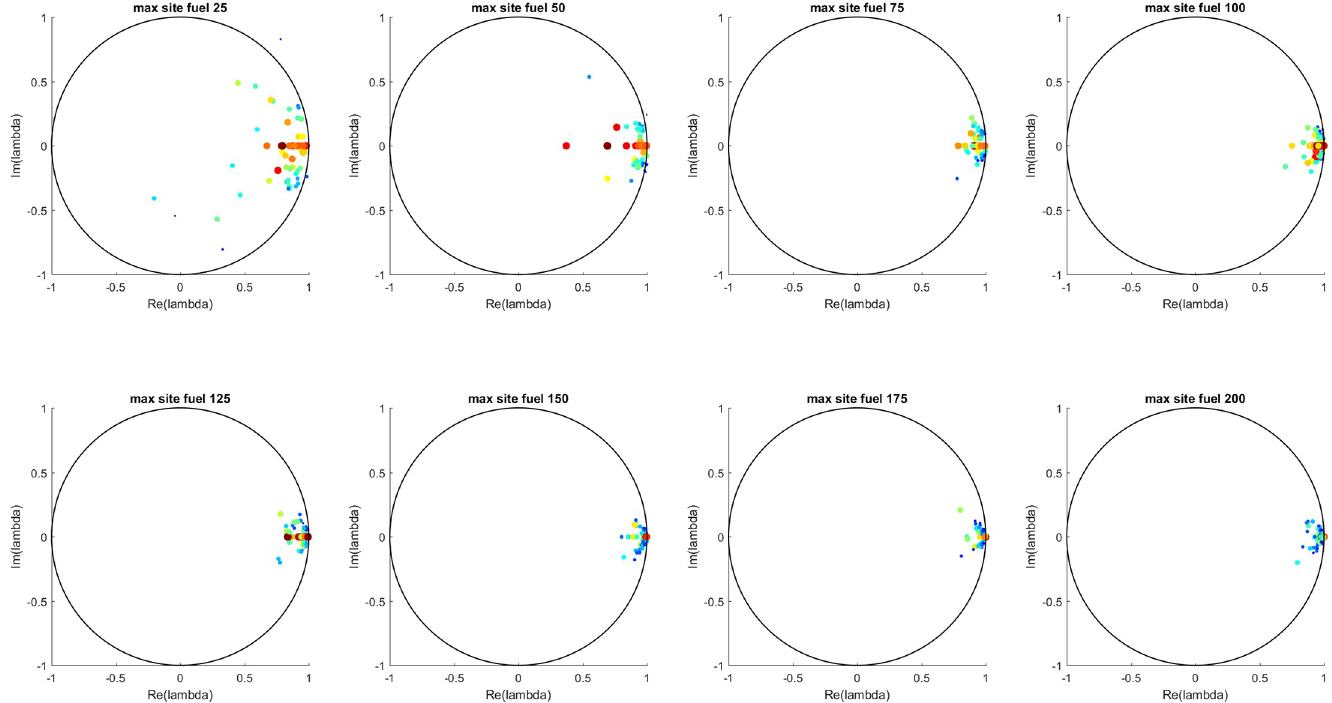
Fig 20. Eigenvalues of second mode for each simulation for each initial fuel value. The eigenvalue color scale (blue to red) shows the L-2 norm of each eigenvalue’s associated Koopman mode. As in the MTF case, the second mode eigenvalues represent the general dependence of the all-eigenvalue case on the maximum site fuel